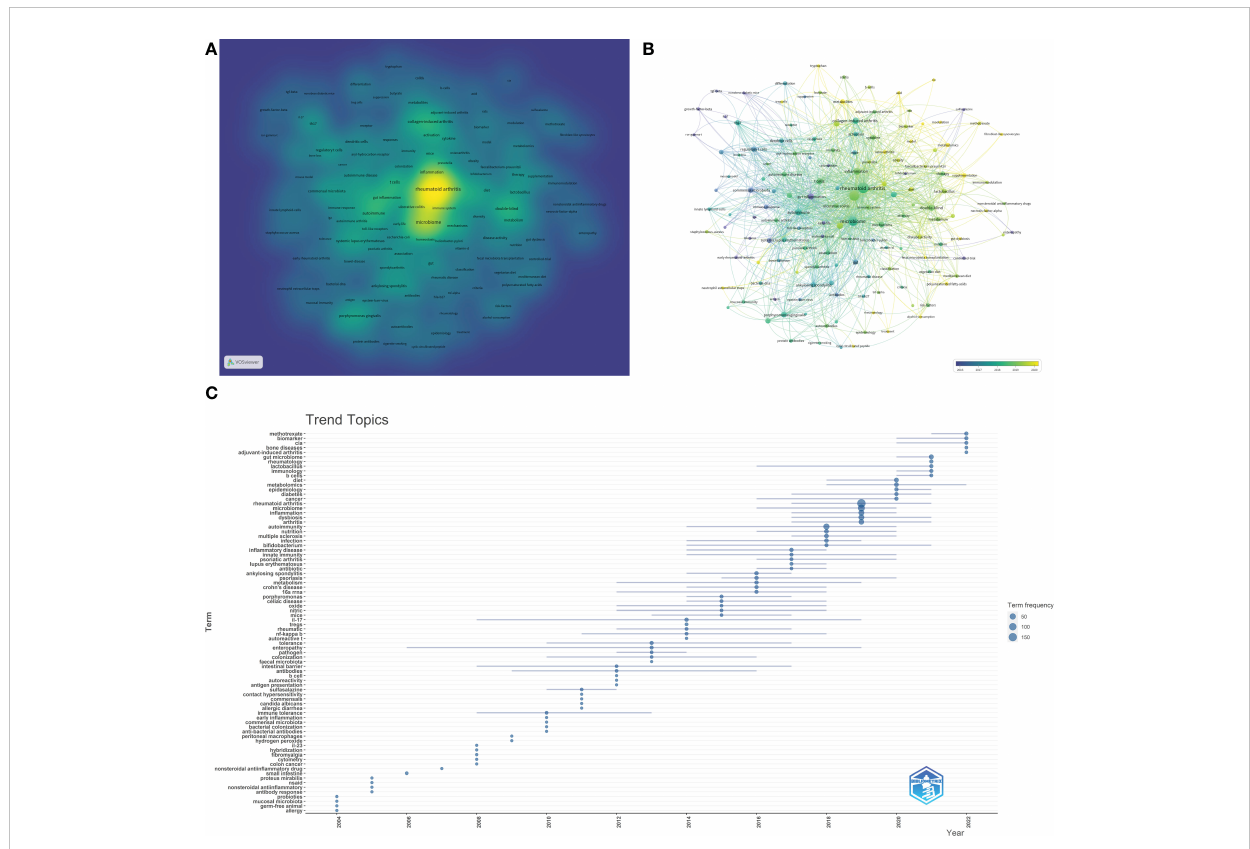
FIGURE 7 Analysis results of hotspot and topic migration in the fi eld of GM in RA. (A) The density visualization of keywords co-occurrence network. (B) The timestamp visualization of keywords co-occurrence network. (C) The historical migration of research hotspots.